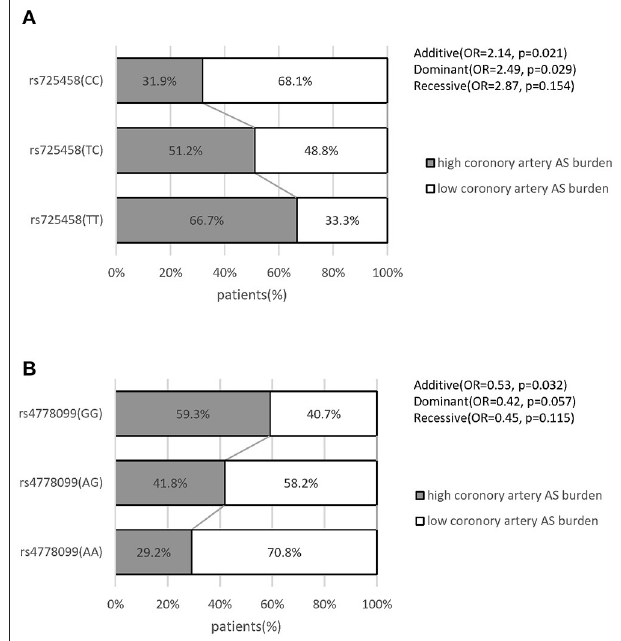
FIGURE 5 | Distribution of coronary artery atherosclerosis burden in patients grouped by genotype and the association with target SNPs in GSE90073. (A) Grouped by rs725458 genotype. (B) Grouped by rs4778099 genotype. All data were collected from the publicly available GSE90073 dataset in